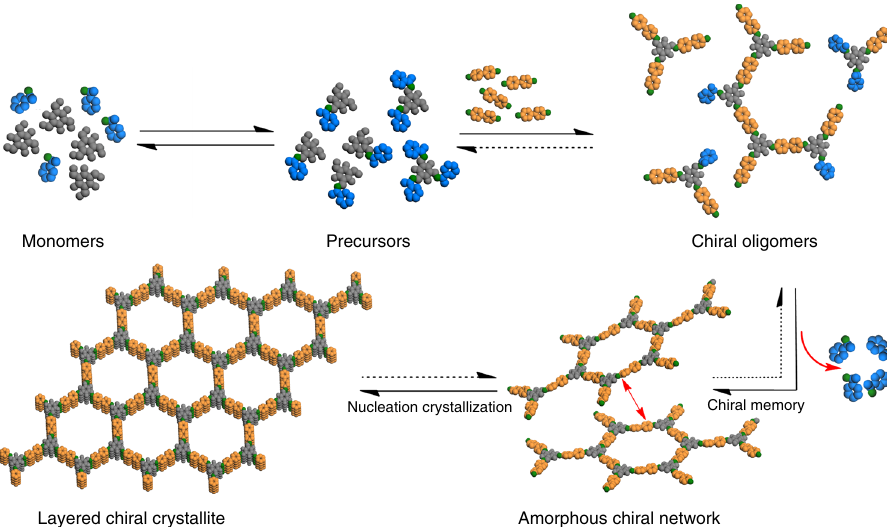
Fig. 5 Proposed models of CCOF-TpBD growth. The enantiomer of 1-PEA was replaced by BD from the precursors, and the chiral memory left in the original position, thereby led to a torsion structure. After then the amorphous polymer crystallized and the CCOF